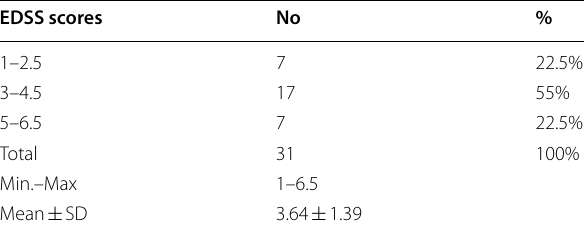
Table 3 Distribution of EDSS scores of the studied group EDSS scores